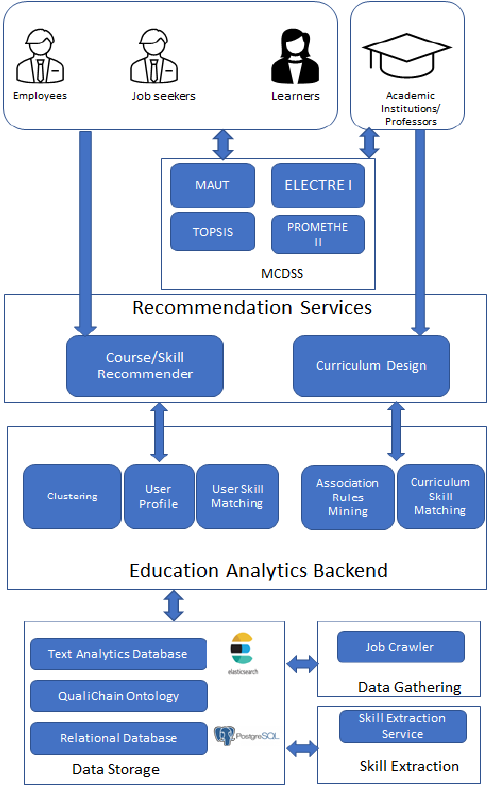
Figure 1. System